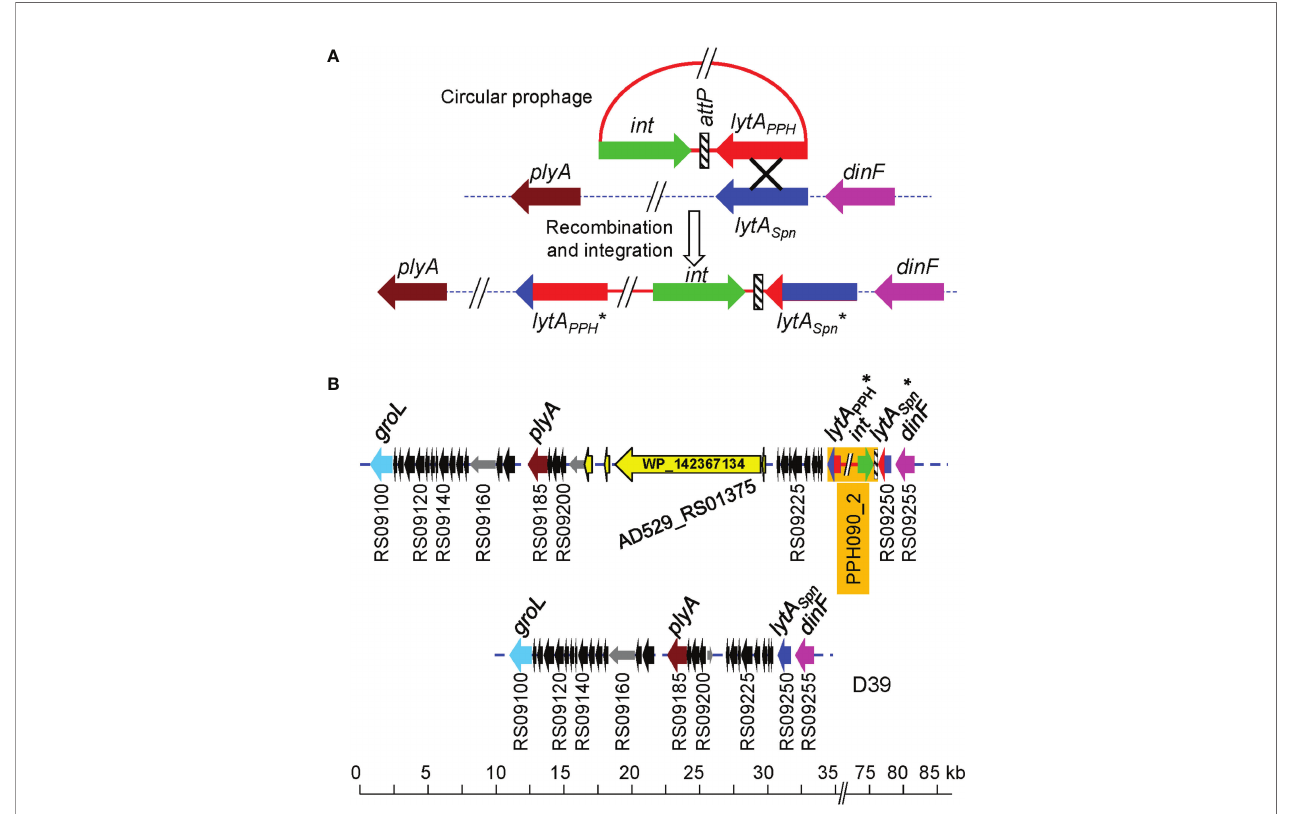
FIGURE 2 | A proposal for phage integration into the S. pneumoniae genome after the recombination of lytA Spn and lytA PPH . (A) The circular phage genome (red) and the pneumococcal chromosome (dotted line) are shown. Genes are drawn as arrows indicating the direction of transcription. An ‘ X ’ indicates the recombination event. The pneumococcal genes plyA and dinF that fl ank the lytA Spn gene are shown for reference (Morales et al., 2015). The asterisk (*) indicates that the phage and bacterial lytA genes were probably chimeric because they contain sequences of both phage and bacterial origin. (B) Novel genomic arrangement of this plyA — lytA island in the pneumococcal strain SMRU257. The location of a gene (AD529_RS01375) encoding a large protein (3628 aa residues; WP_142367134) is shown. For comparison, the corresponding DNA region of the control D39 strain is shown at the